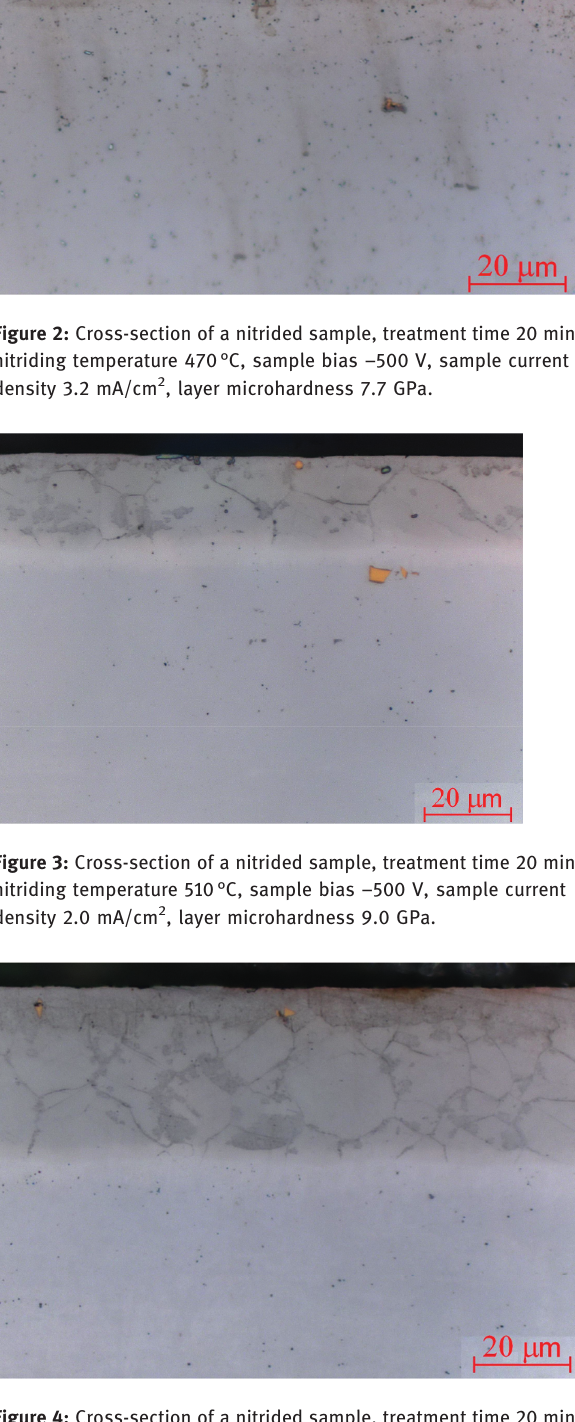
Figure 4: Cross-section of a nitrided sample, treatment time 20 min, nitriding temperature 565°C, sample bias – 500 V, sample current density 2.6 mA/cm 2 , layer microhardness 9.1 GPa.